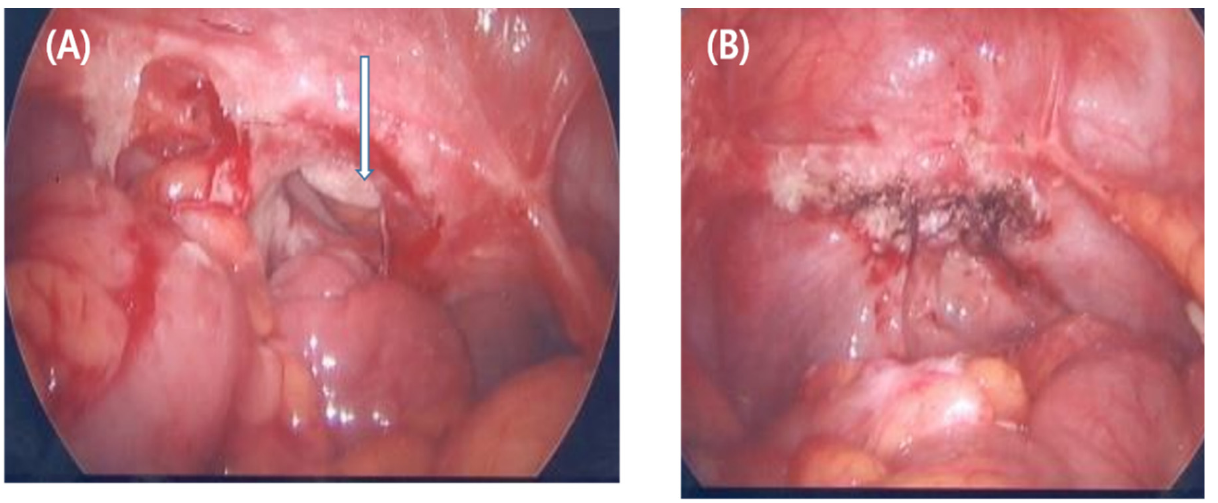
Figure 1. Flow diagram of the study cohort.